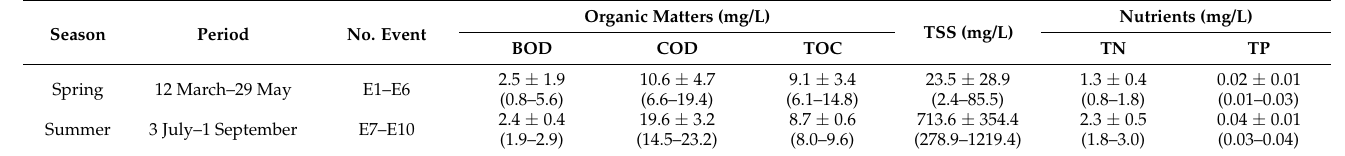
Table 4. Summary of event mean concentrations of pollutant parameters (BOD, COD, TOC, TSS, TN and TP) in the immediate post-fire